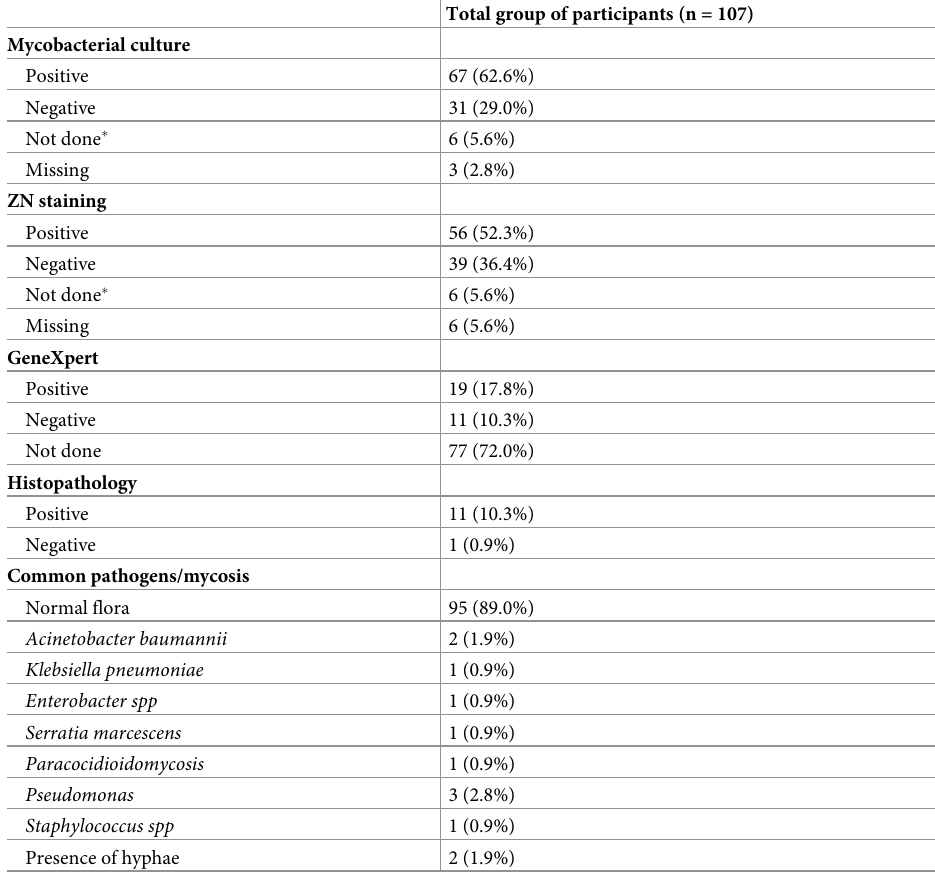
Table 2. Microbiological